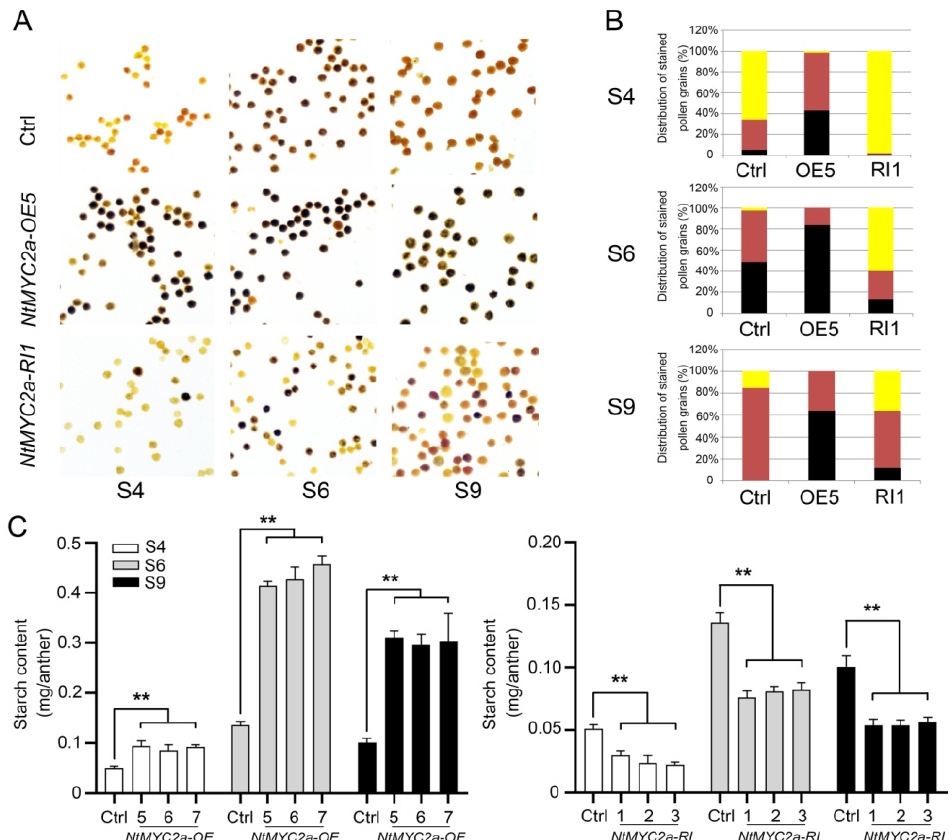
Figure 2. NtMYC2a regulates starch accumulation of pollen. ( A ) Pollen grains of NtMYC2a -OE, NtMYC2a -RI and control plants at S4, S6 and S9 stained by I 2 /KI solution; ( B ) Distribution of stained pollen grains in NtMYC2a -OE, NtMYC2a -RI and control plants at S4, S6 and S9. The distribution of stained pollen grains is shown as a percentage of total grains (5000 grains) counted for each of the iodine staining intensity categories. The black, brown and yellow boxes correspond to dark-stained, light-stained and unstained pollen grains, respectively. For each stage, five flowers were sampled from five different plants, and 1000 pollen grains were counted in each flower. In total, 5000 pollen grains were counted at each stage, giving standard error values that are very small and, thus, are not shown here; ( C ) Analysis of starch content in pollen grains at indicated floral development stages. Data are shown as means ± SD. Significant differences from the data of control plants are indicated: ** p < 0.01 (Student’s t -test).